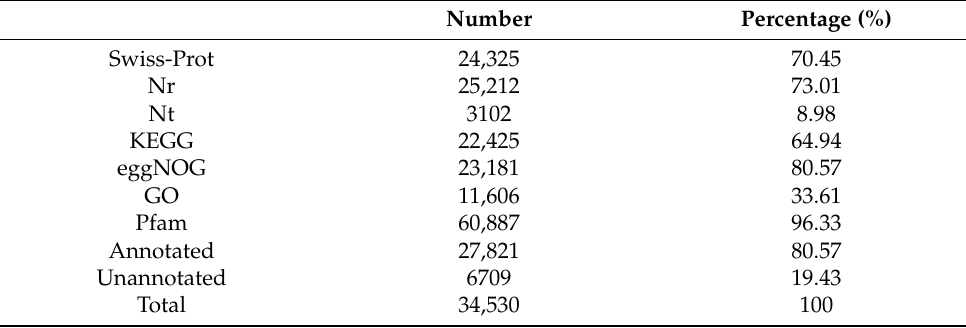
Table 8. Statistics of gene function annotation for the M. chilensis